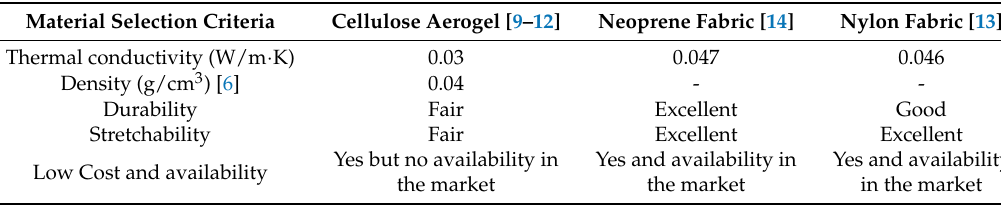
Table A3. Insulating Material Selection.